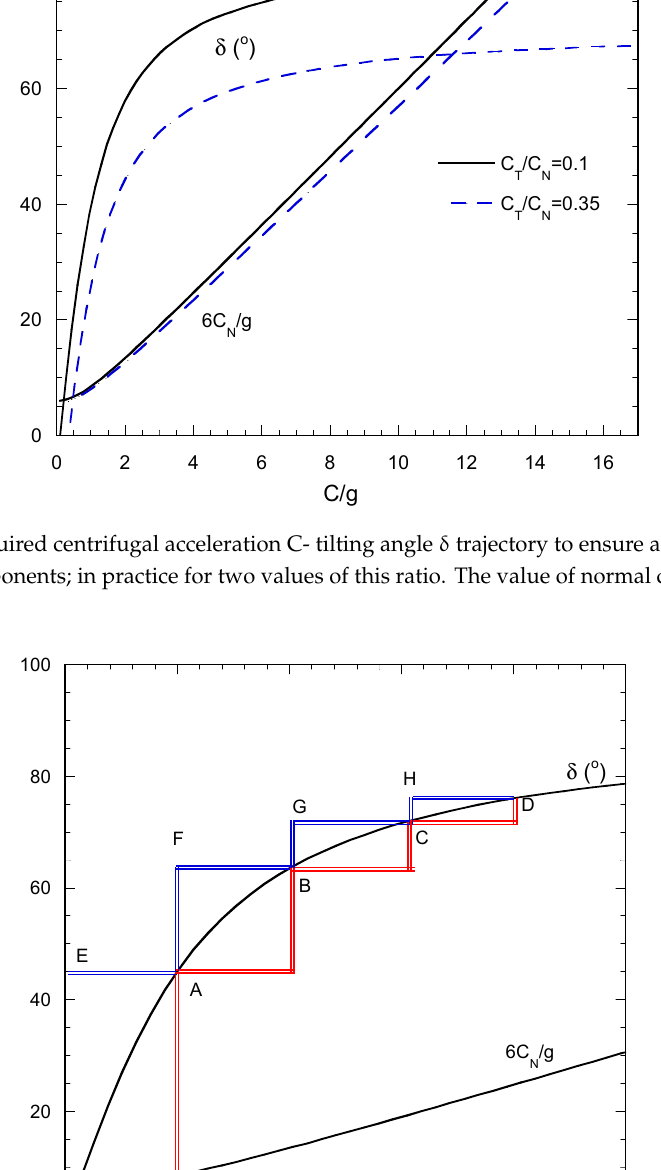
F Figure 10. Droplet profiles at different positions along the blue (left) stepwise trajectory in Figure 9 (V A = 5 mm 2 , θ a = 60°, θ o = 60°, Bo N = C N /2.5).